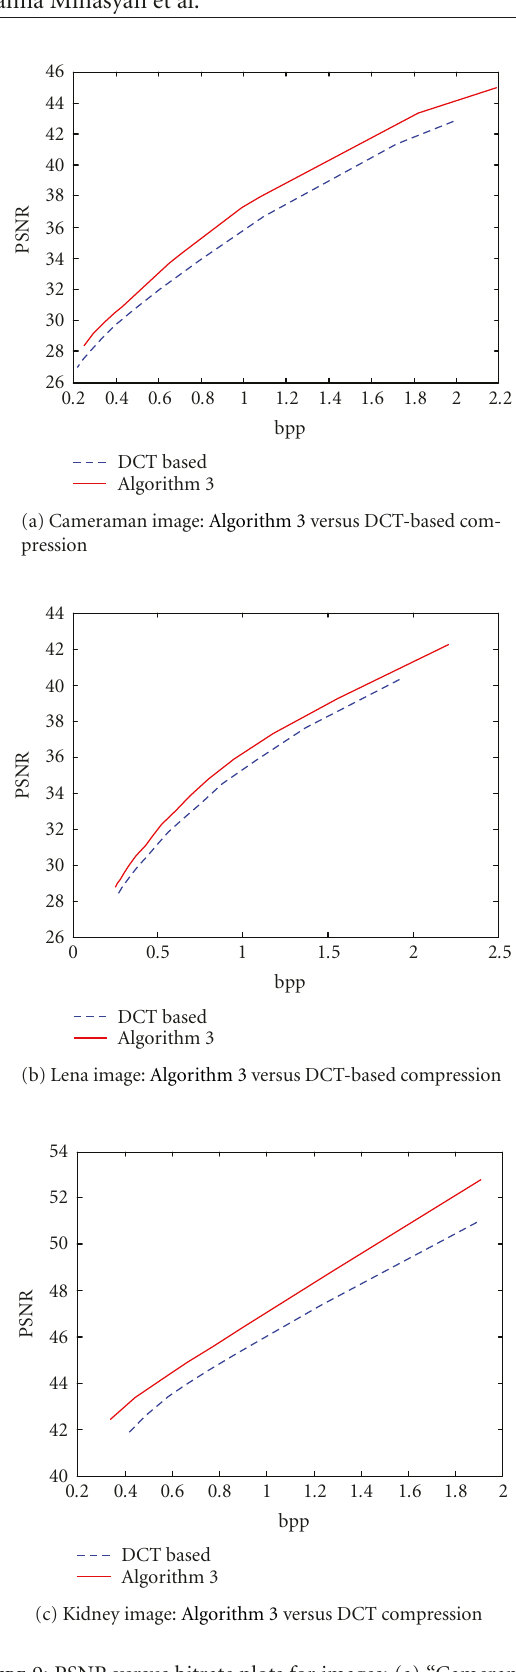
Figure 9: PSNR versus bitrate plots for images: (a) “Cameraman;” (b) “Lena;” (c) “Compound.” For all images c = 0 . 5, Q = 8 ··· 80, q 1 = Q , q 2 = 0 . 9 Q , q 3 = 08 Q .